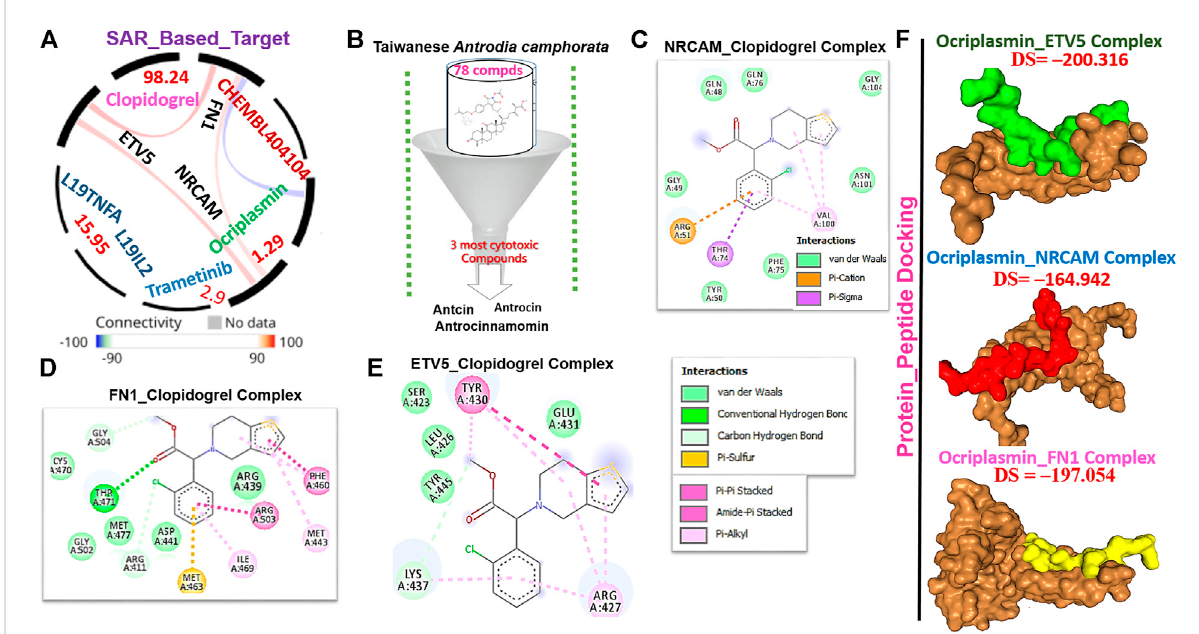
FIGURE 9 Drug target identi fi cation and molecular docking study of clopidogrel (synthetic compound) or ocriplasmin with the t hyroid tumor-enriched protein (TTEP). (A) Target connectivity mapping of FN1/ETV5/NRCAM. (B) Sorting and identi fi cation of potent phytocompounds from Antrodia camphorata. Molecular docking pro fi le of clopidogrel with (C) FN1, (D) NRCAM, and (E) ETV5. (F) Protein – peptide docking of ocriplasmin with FN1/